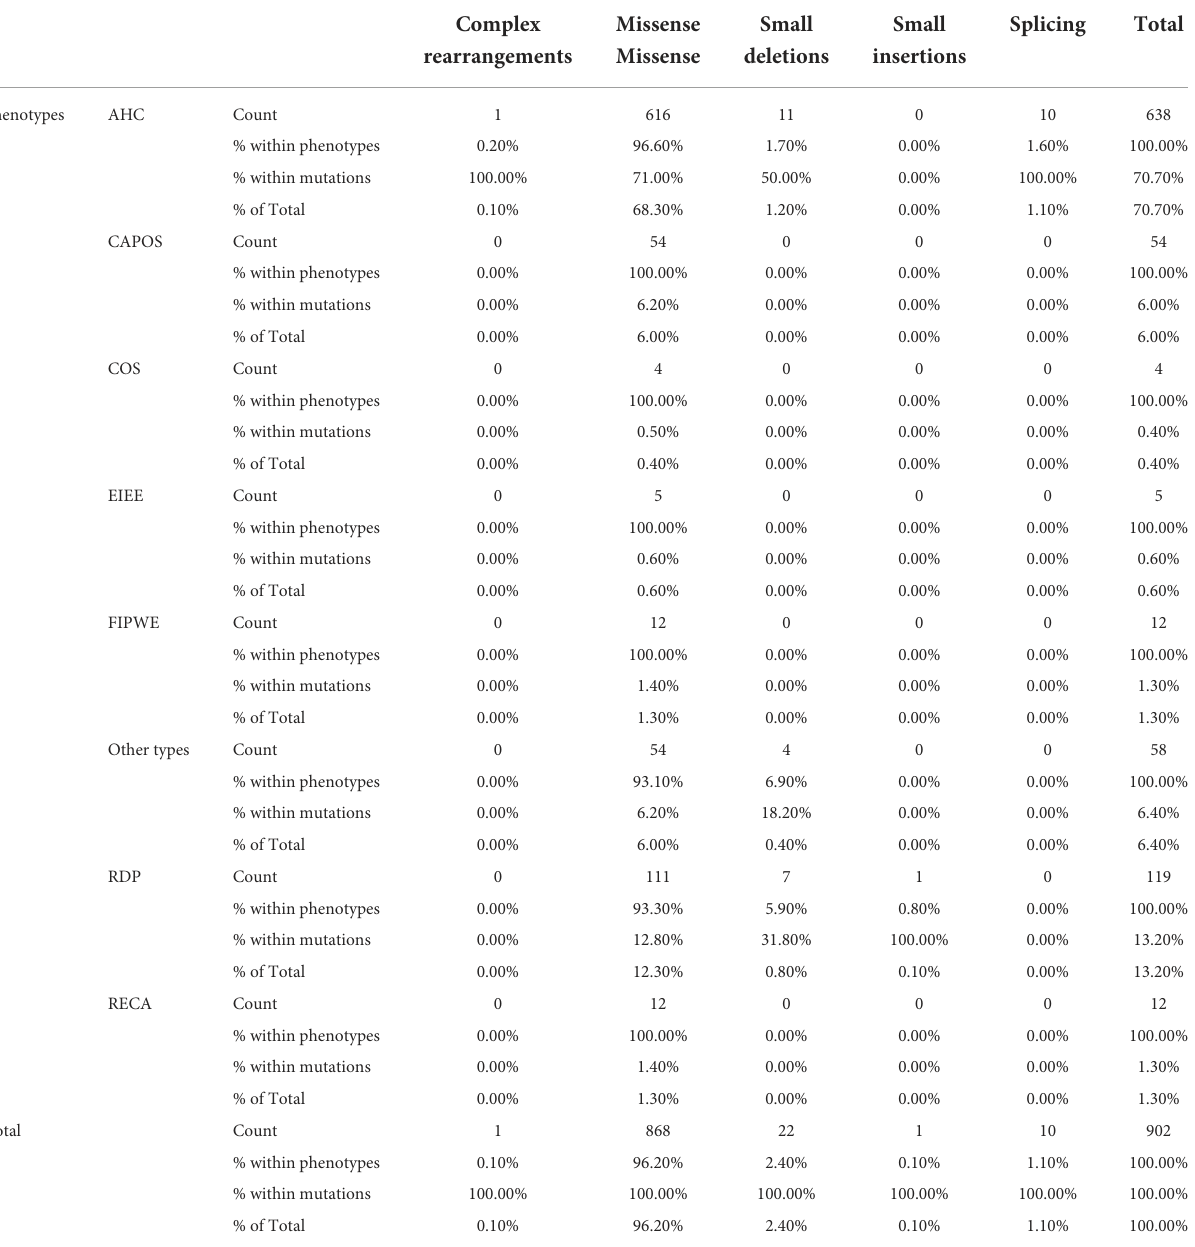
TABLE 1 Relationship between ATP1A3 mutation types and